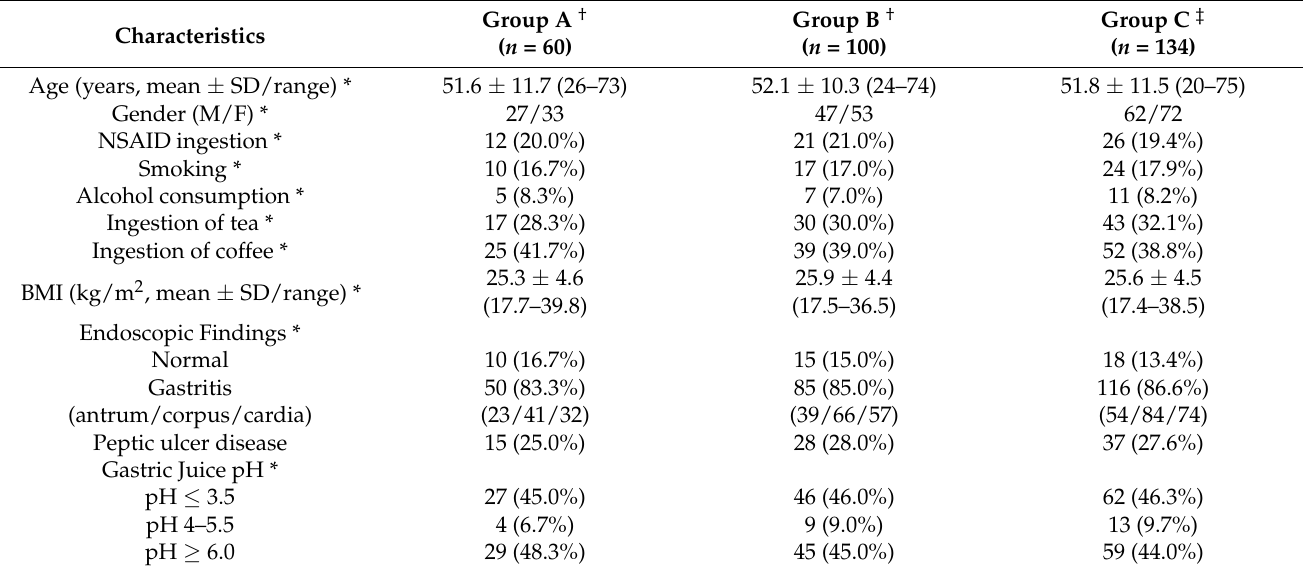
Table 2. Clinical characteristics of Helicobacter pylori infected